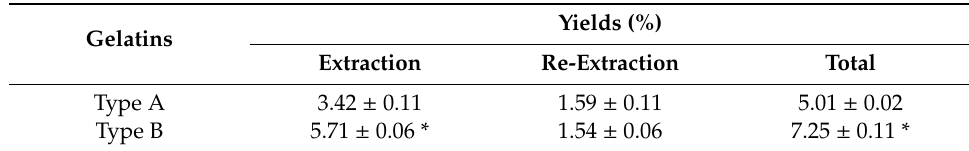
Table 4. Yields (%, Dry weight gelatin / wet weight sample) of gelatins extracted from the head of Kalamtra sturgeon.